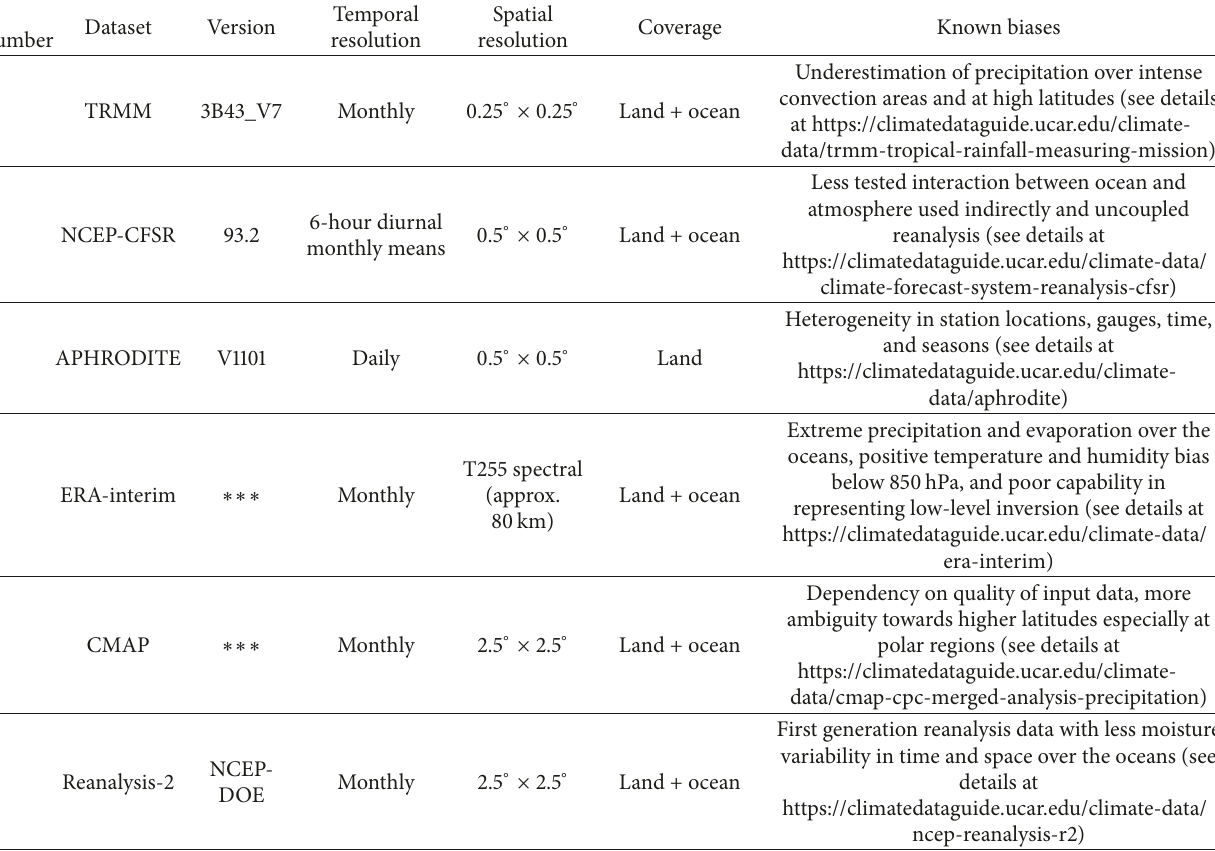
Table 2: List of observation and reanalysis datasets used in validating the current study. The known biases are mentioned along with the temporal and spatial